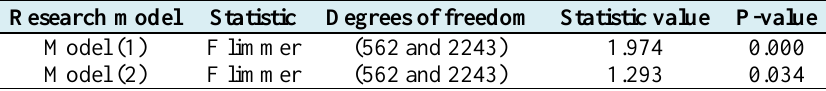
Table 17. The results of the F limmer test in the BSE